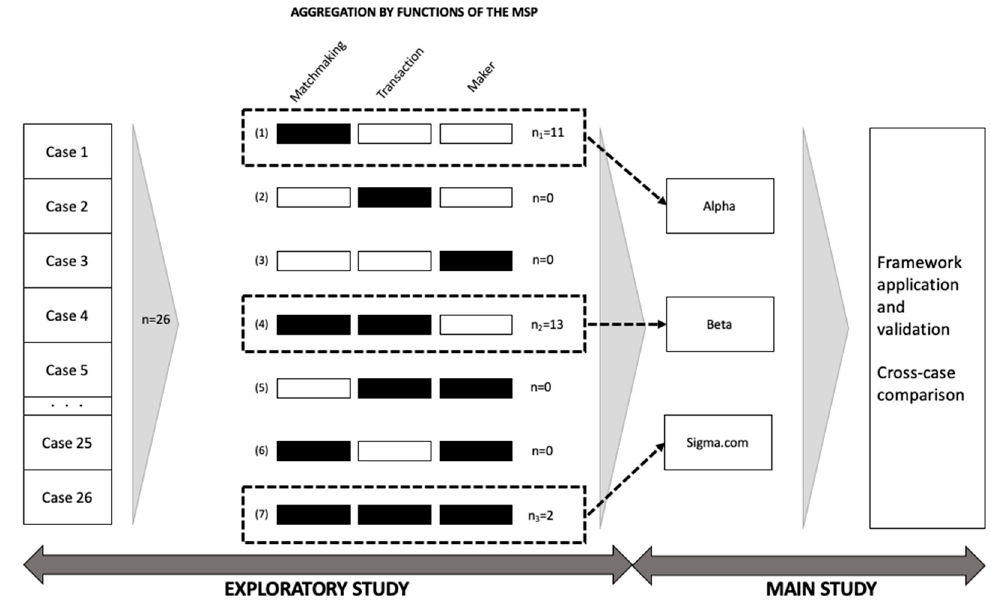
Figure 2. The structure of the empirical analysis.